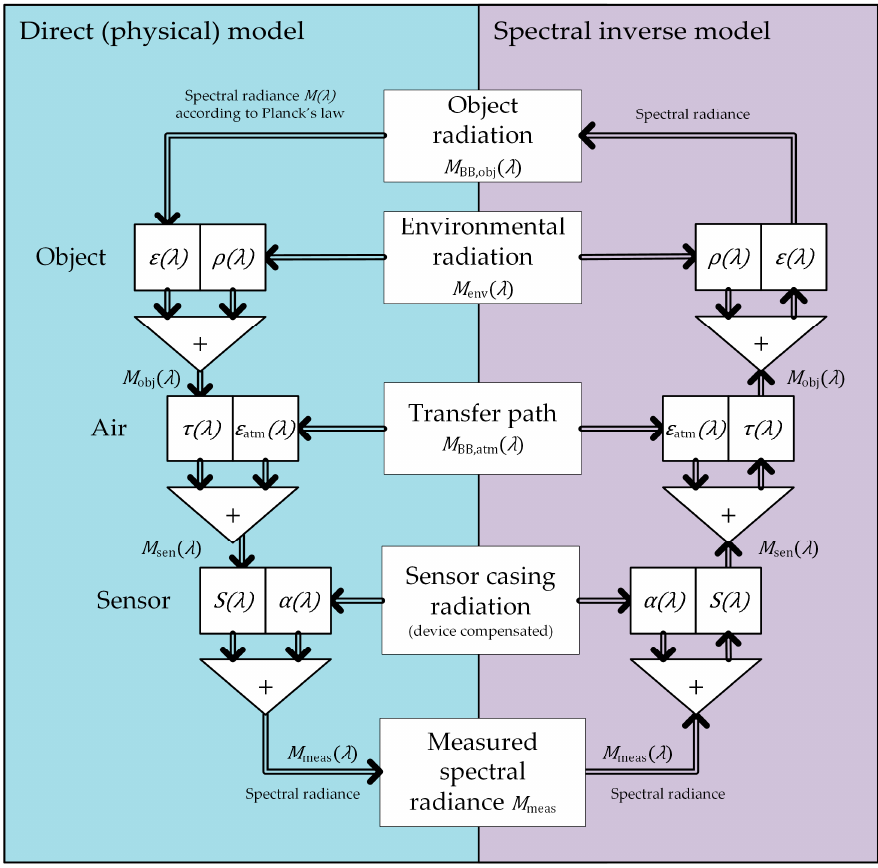
Figure 9. Theoretically ideal inverse of the direct model. Note that spectral integration is irreversible upon measurement. Therefore, measurement of spectral radiance is required for the ideal inverse model. Spectral integration was omitted from the direct model.